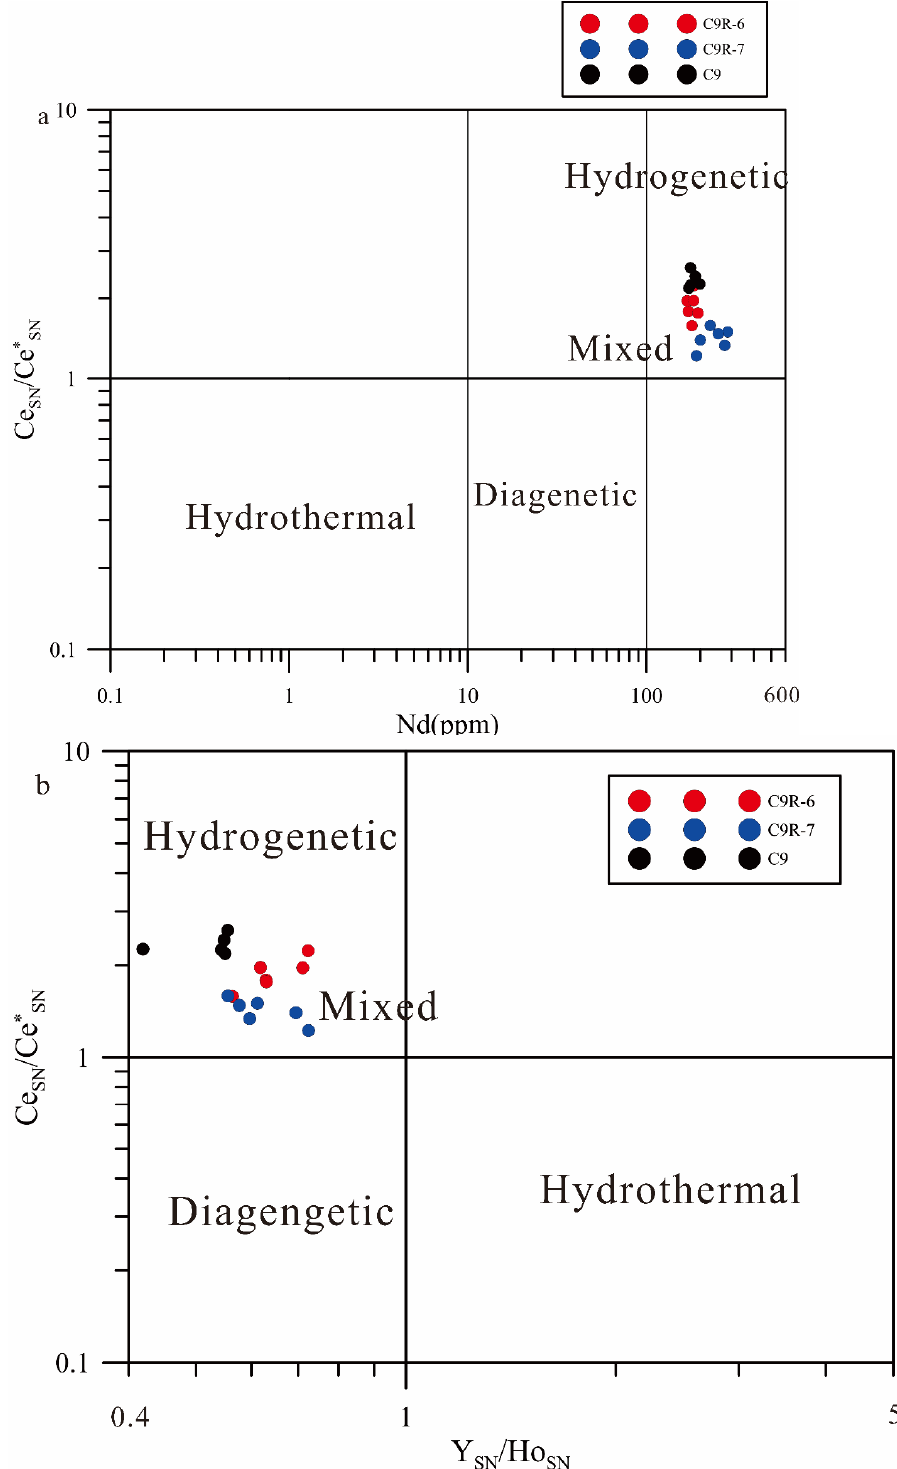
Figure 9. Discrimination graphs of ferromanganese deposits from Caiwei Guyot. ( a ) Ce SN /Ce SN* ratios vs. Nd contents. ( b ) Ce SN /Ce SN * ratios vs. Y SN /Ho SN ratios.